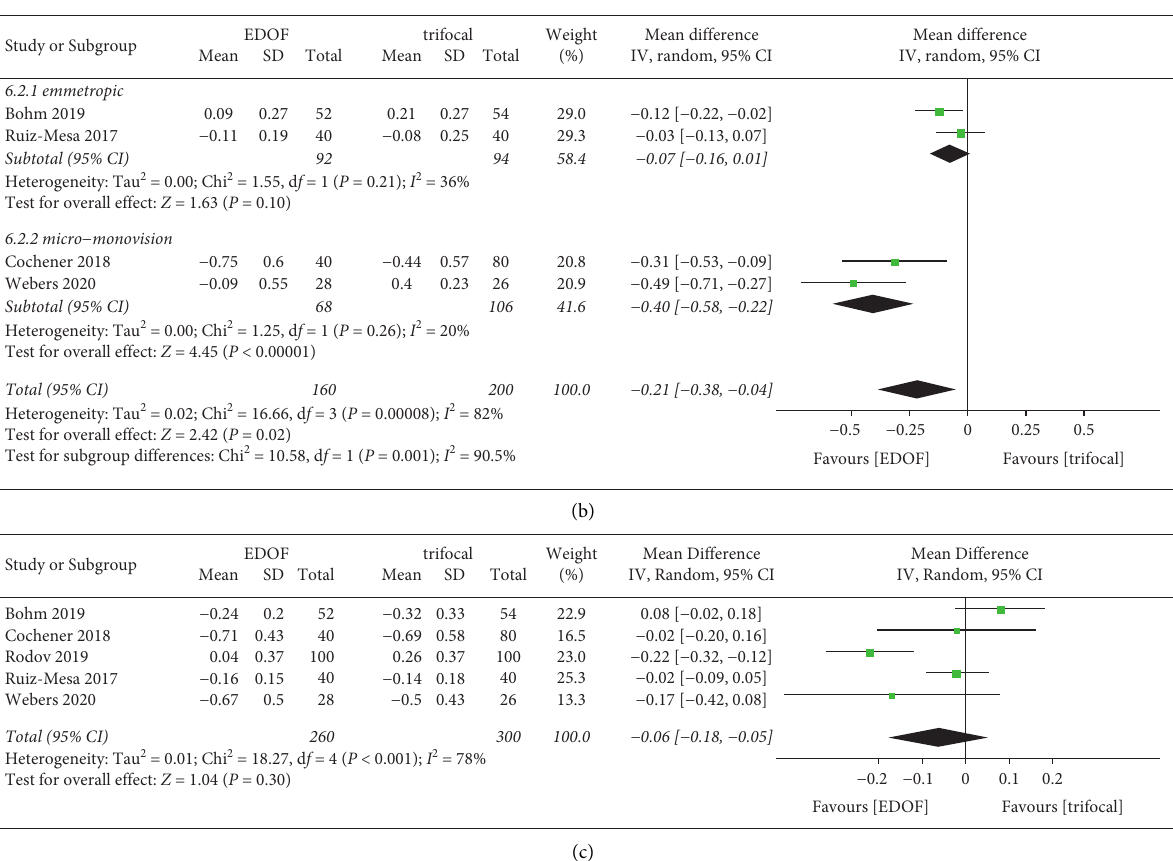
Figure 9: Forest plot of postoperative refraction. (a) Spherical equivalent; (b) residual sphere; and (c) residual astigmatism. EDOF, extended depth-of-focus; SD, standard deviation; CI, confidence interval; IV, inverse variance.